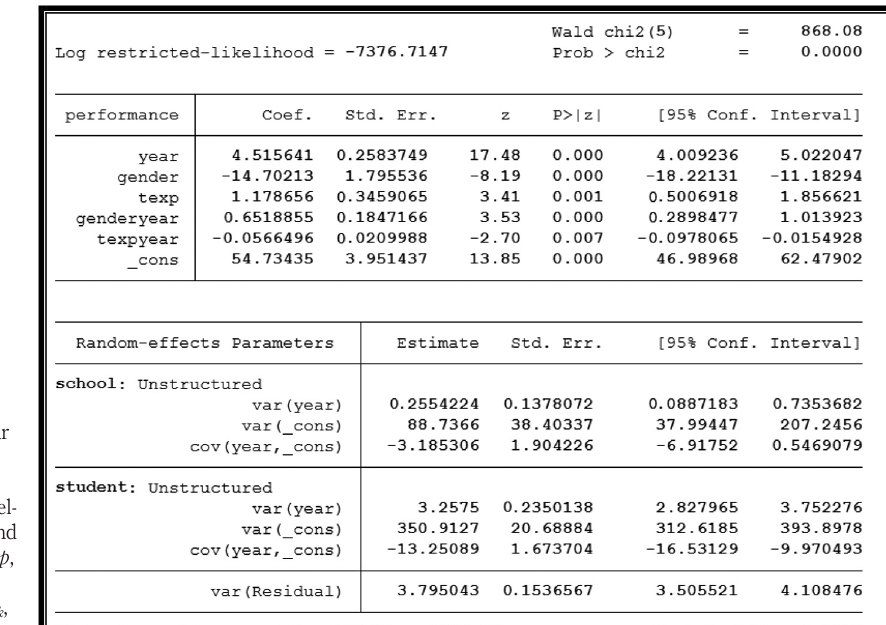
Figure 13. Outputs of the linear trend model with random intercepts and slopes and Level- 2 variable gender and Level-3 variable texp , with correlated random effects ( u 00 k , u 10 k ) and ( r 0 jk , r 1 jk